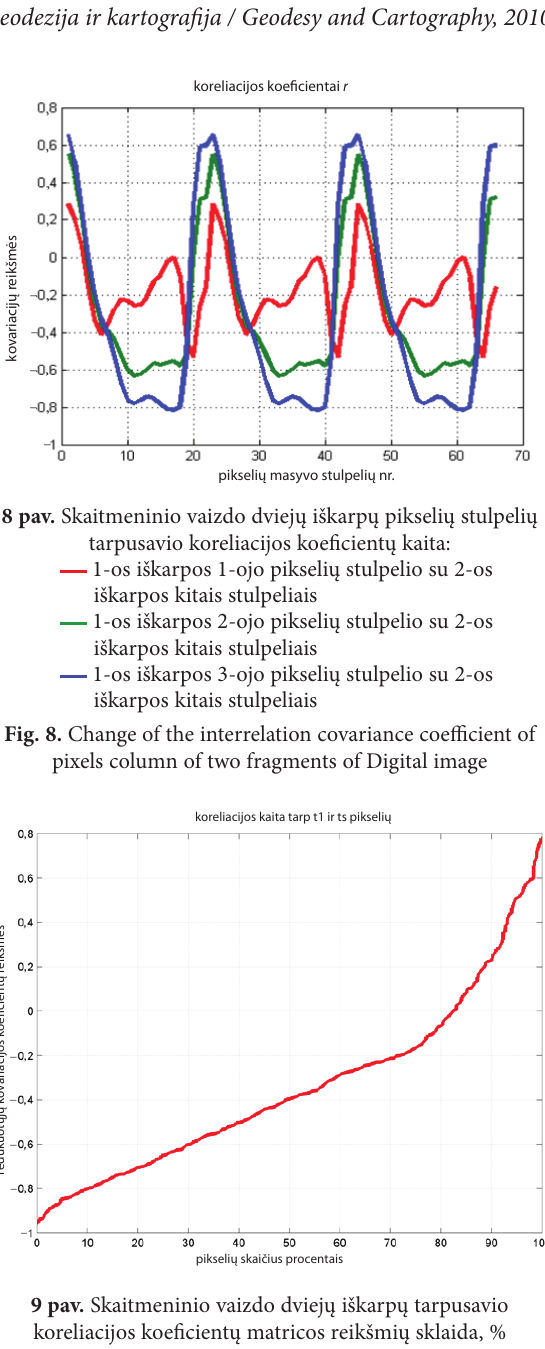
Fig. 9. Change in percents of the interrelation covariance coefficient of matrix meaning (significance) of two fragments of Digital